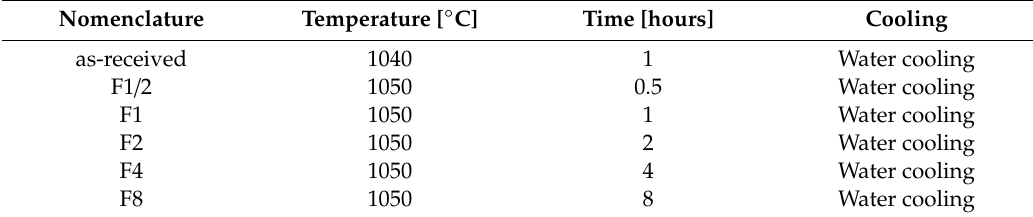
Table 2. Solution-annealing parameters applied to each